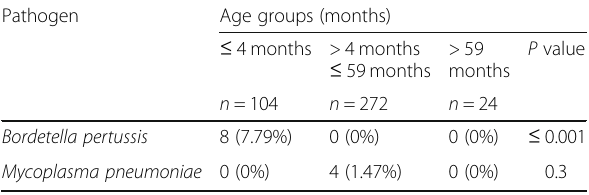
Table 3 Correlating the frequency of pathogen detection